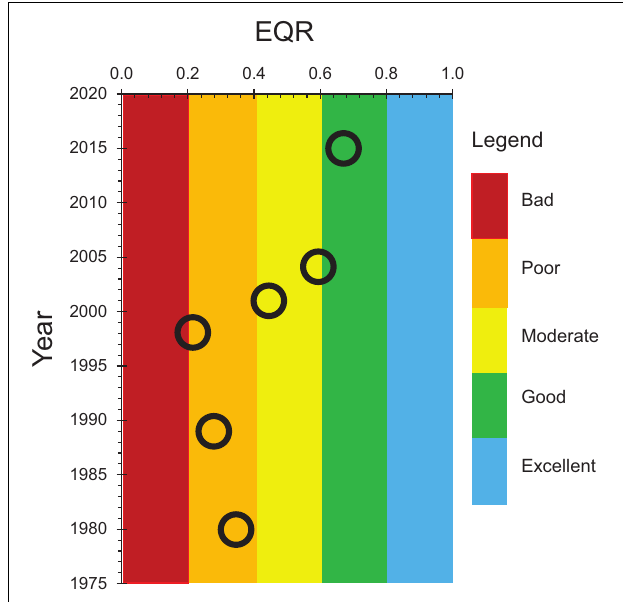
FIGURE 6 | Ecological Quality Ratio (EQR) in core SP5 as a function of year. The classification of EQR values (in accordance with Van de Bund and Solimini (2007) are